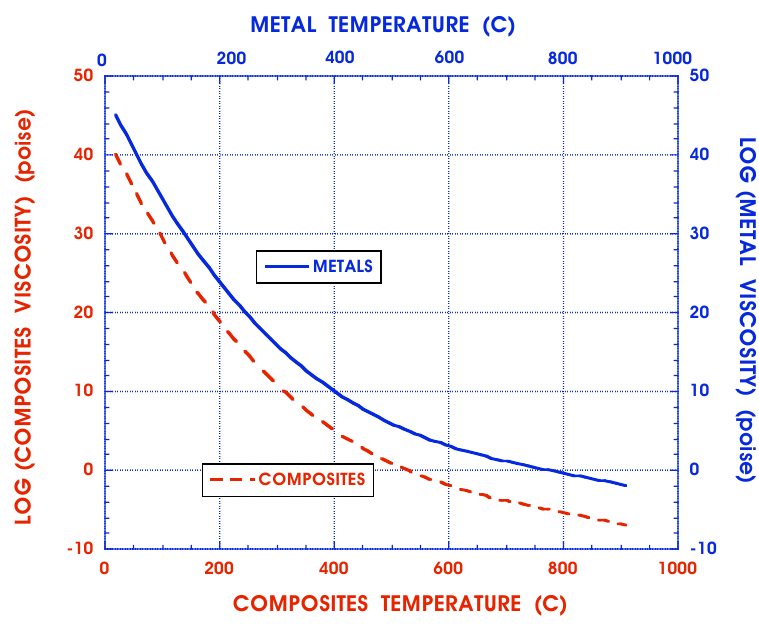
Figure 1. Coefficients of viscosity for metals and composites.